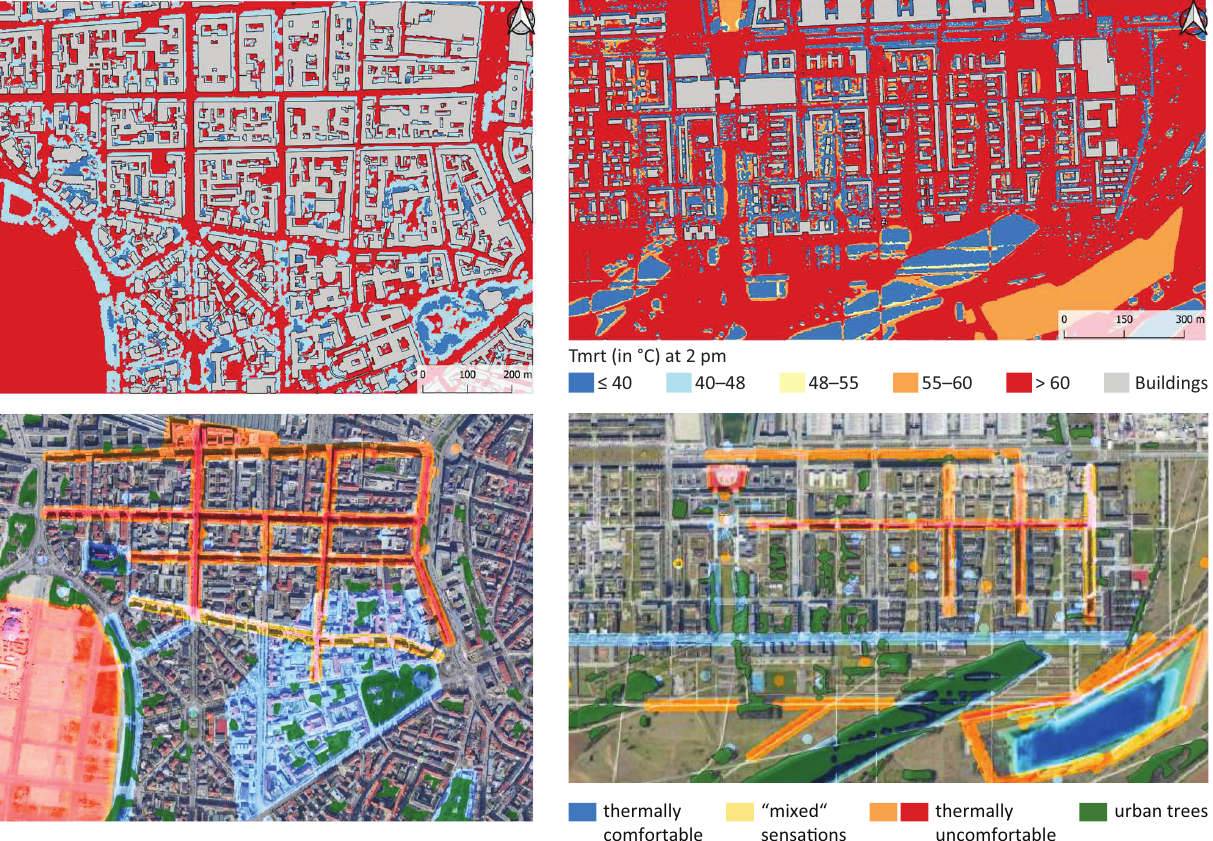
Figure 6. T model results for 25th July 2019 at 2 pm (top) and perceived thermal comfort maps (bottom) for mrt Bahnhofsviertel (left) and Messestadt (right). The colour intensity in the subjective heat maps reflects the number of times the area or location was